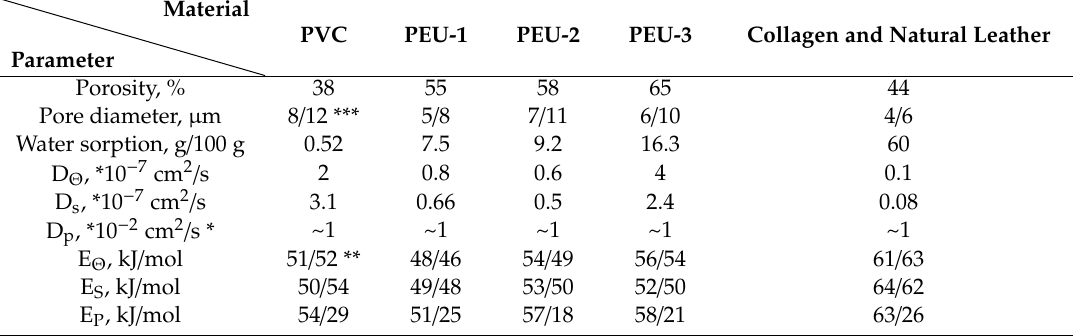
Table 1. Characteristics and kinetic constants of di ff usion and permeability of porous polymeric membranes of di ff erent hydrophilicity at 298